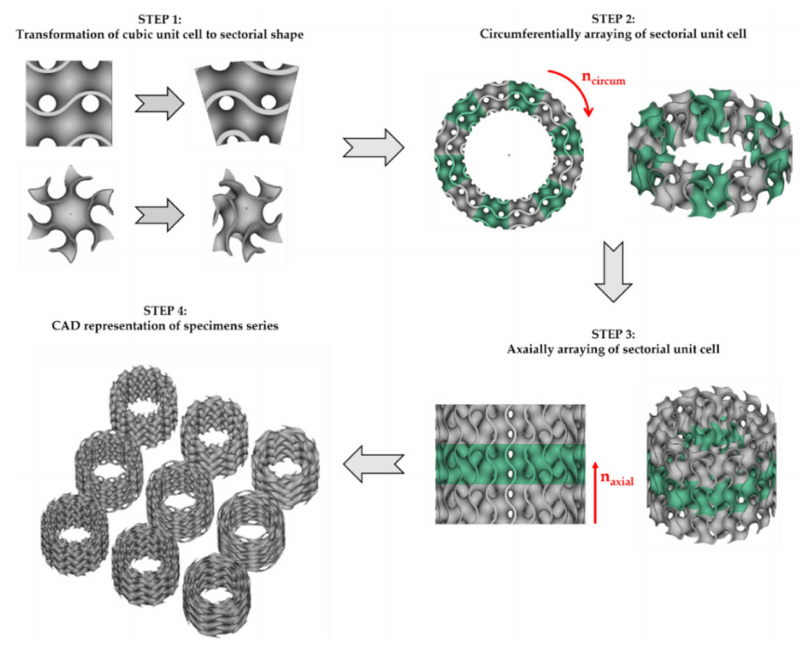
Figure 3. The design process of cylindrically mapped TPMS structures with shell gyroid unit